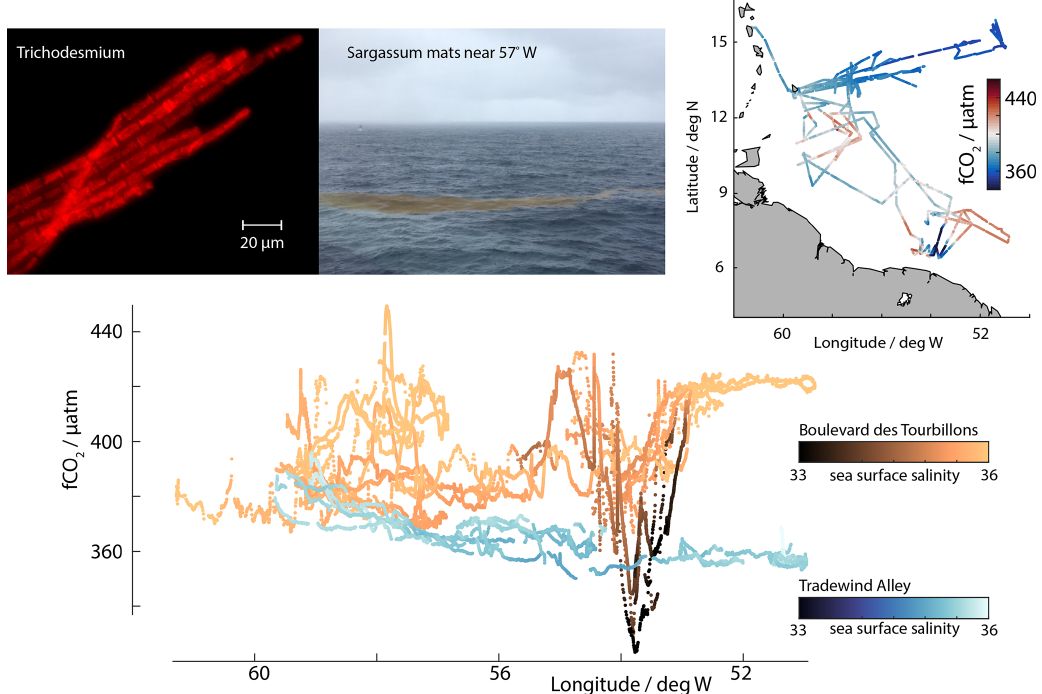
Figure 18. CO 2 fugacity ( f CO 2 ) measurements from different surface vessels (upper right) and versus longitude (lower). The presentation contrasts strong variability in f CO 2 in association with eddies and salinity variations along Boulevard des Tourbillons (orange in lower panel, track in upper right) versus in the Tradewind Alley (blues). Microscopic/epifluorescence image of several filaments of Trichodesmium , an N 2 -fixing cyanobacterium that is found in the region (upper left), and mats of seaweed ( Sargassum , photo by Wiebke Mohr, upper center) which were frequently observed and difficult to navigate from some of the uncrewed surface